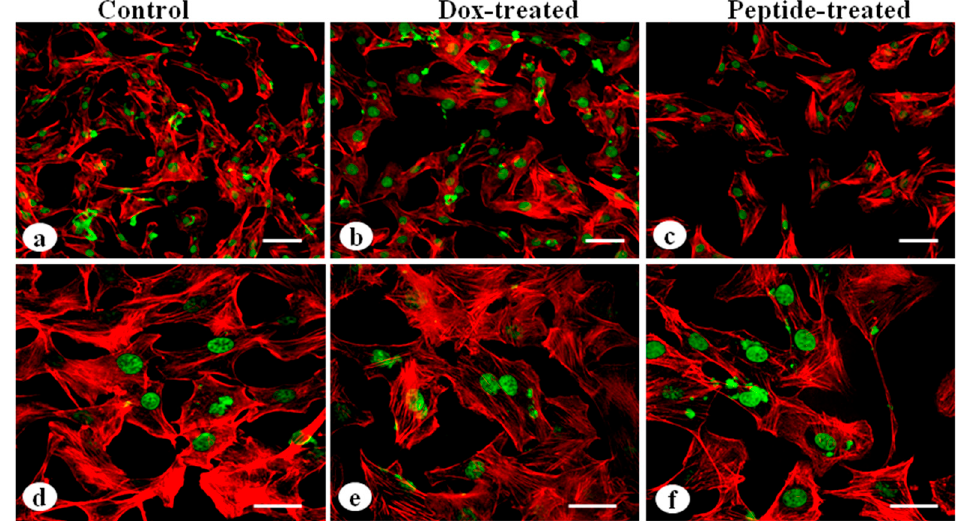
Figure 8. Cytoskeletal organization of MDA ‐ MB ‐ 231 cells by actin immunostaining: a ) and d ) MDA ‐ cells without treatment, ( b , e ) MDA-MB-231 cells treated with doxorubicin, ( c , f ) cyclosaplin treated MB ‐ 231 cells without treatment, b ) and e ) MDA ‐ MB ‐ 231 cells treated with doxorubicin, c ) and f ) MDA-MB-231 cells (Scale bar = 50 µ m and 20 µ cyclosaplin treated MDA ‐ MB ‐ 231 cells (Scale bar = 50 μ m and 20 μ m).